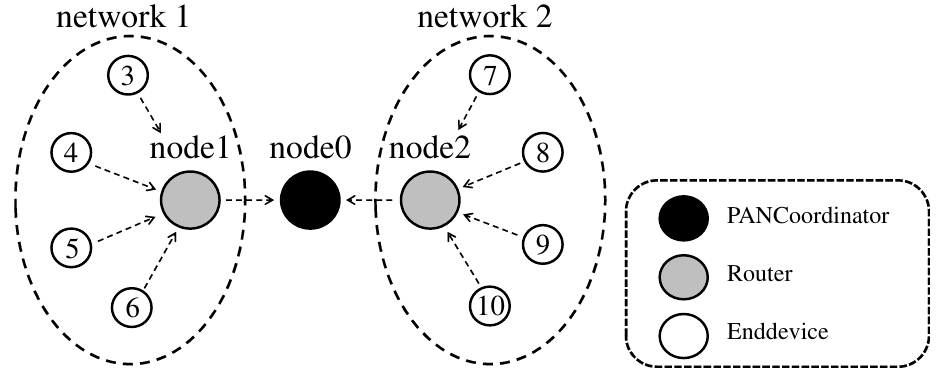
Figure 7. Network topology in the